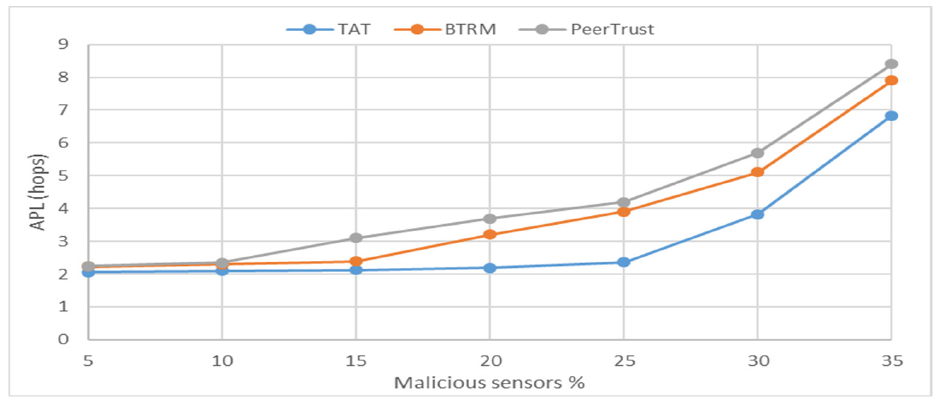
Figure 7. APL for TAT, PeerTrust, and BTRM Models.